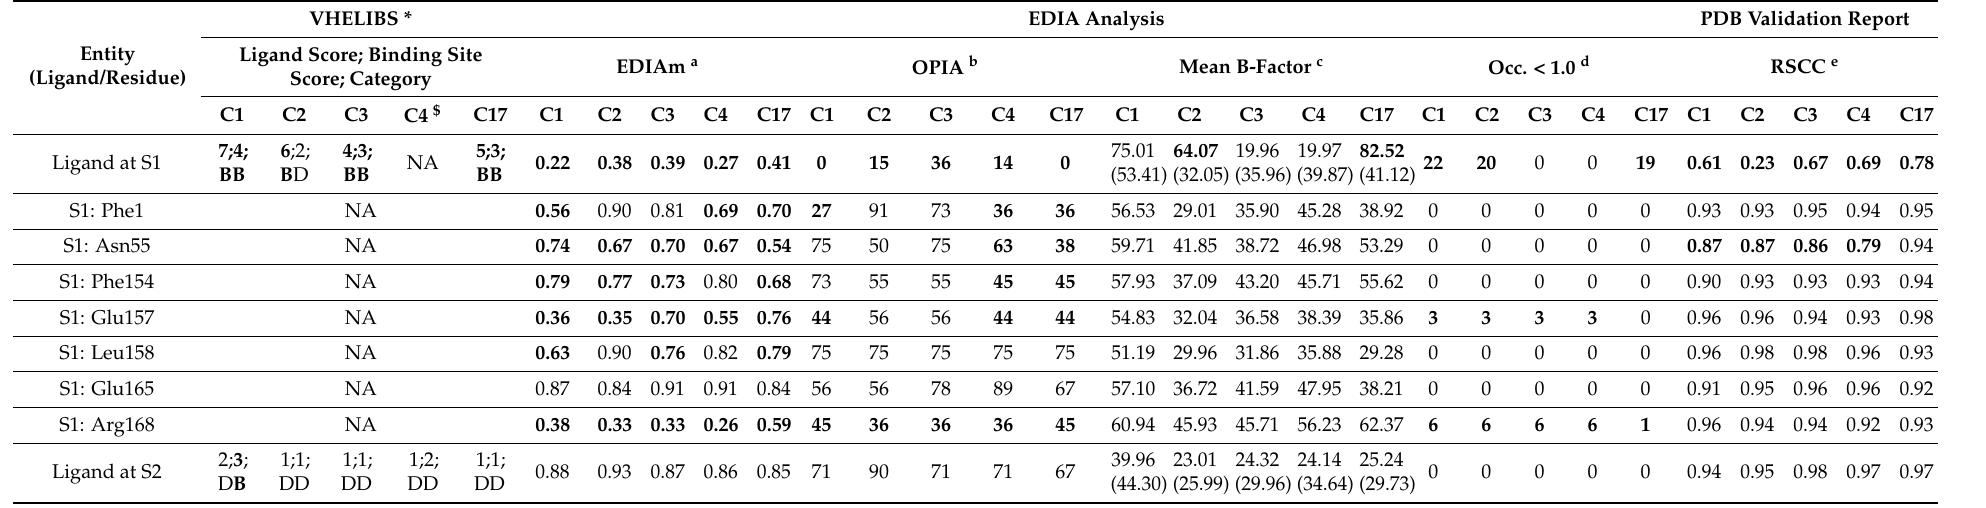
Table 1. Quality assessment of protein–ligand binding sites in C1–C4, and C17 (case